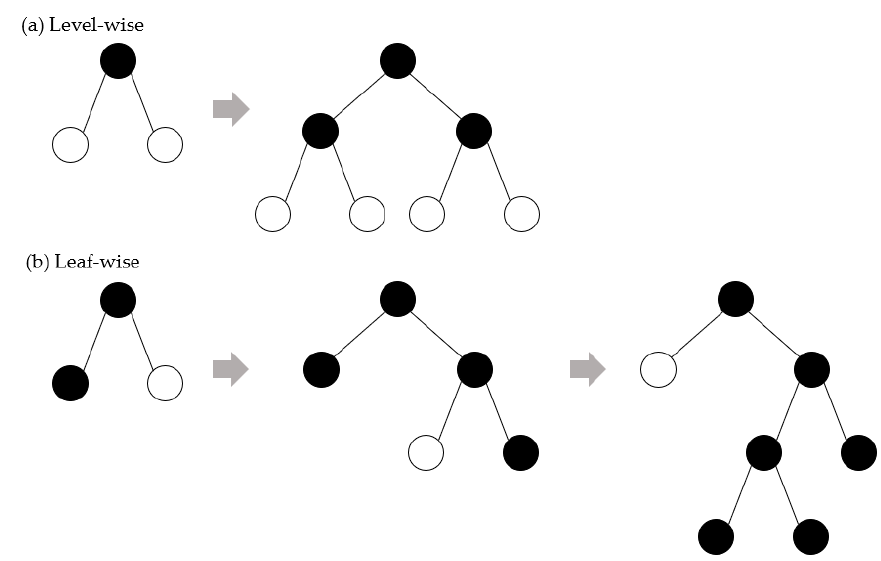
Figure 1. ( a ) Level-wise tree growth; ( b ) leaf-wise tree growth.